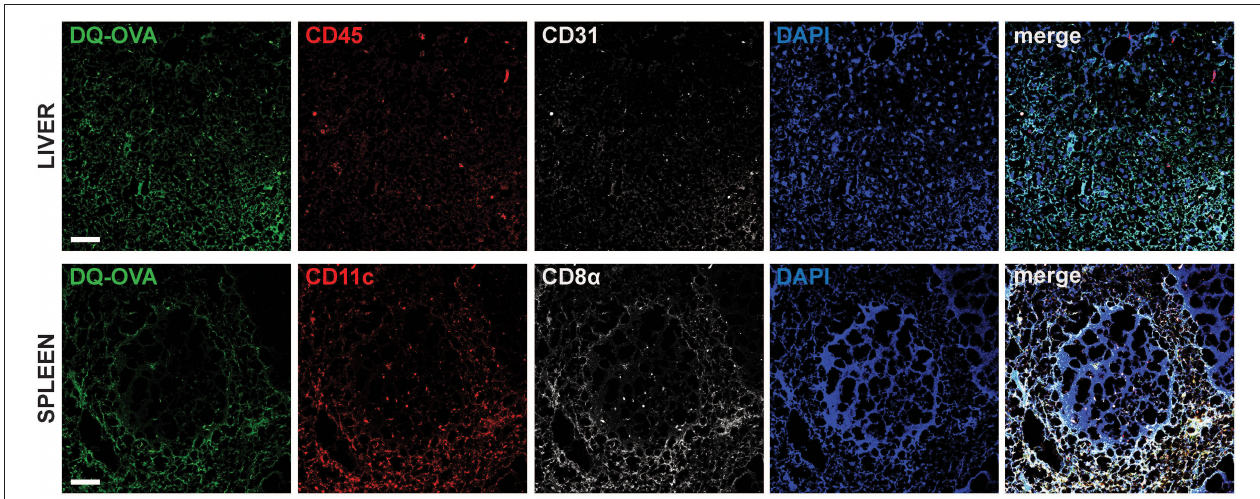
FIGURE 2 | Intravenously administered soluble antigens are processed by liver CD45 − CD31 − parenchymal cells and CD11c + CD8 α + splenocytes. Twelve hours after i.v. administration to C57BL/6 mice, processed DQ-OVA is found within CD45 − CD31 − parenchymal cells of the liver (hepatocytes) (top row) and in CD11c + CD8 α + cells of the spleen (bottom row). Scale bar = 50 µ m. Pictures are representative of 5 different